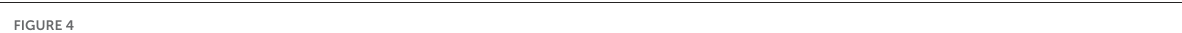
FIGURE4 again IP with LPS or P3C (Sham controls were IP injected with saline). The expression of TNF α , IL-1 β , Gal-3, NLRP3 and MHC II was determined by qPCR, and normalized to the expression of GAPDH. In WT and TLR2 − / − animals that received the two stimuli the expression levels of TNF α , IL-1 β and Gal-3 were increased [ICV NA and P3C or LPS, in (B,D,F) ] compared to mice of the same strain with a single stimulus [ICV Sal in (A,C,E) and Sham groups in (B,D,F) ]. The same tendency occurred for NLRP3, although the increase was milder (G,H) . Conversely, in TLR4 − / − mice the second stimulus was only able to induce a slight increase in the expression of TNF α (B) and IL-1 β [ (D) although not significant compared to ICV Sal in (A) ], and for both genes such increase was to a lesser extent to that observed in WT [WT-P3C in (B,D) ]. The expression of MHC II did not change significantly in any experimental group (I,J) . Bars in histogram represent the mean ± s.d. of the plotted points, each of which obtained from a different mouse [ n = 3–4 in (A,C,E,G,I) ; n = 5–7 in (B,D,F,H,J) ]. Means were compared by three-way ANOVA ( P = 0.007). Letters a, b and c on top of the bars point to the absence (if the same letter appears) or existence (if different letters appear) of a significant difference between the compared groups, carried out by the Tukey’s test ( P < 0.05).